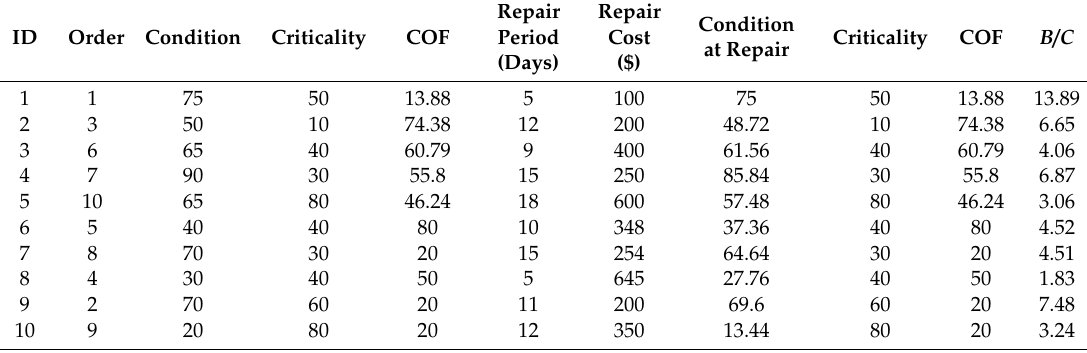
Table 1. Genetic algorithm input and output Excel sheet (COF, consequence of failure; B/C , benefit-to-cost ratio).